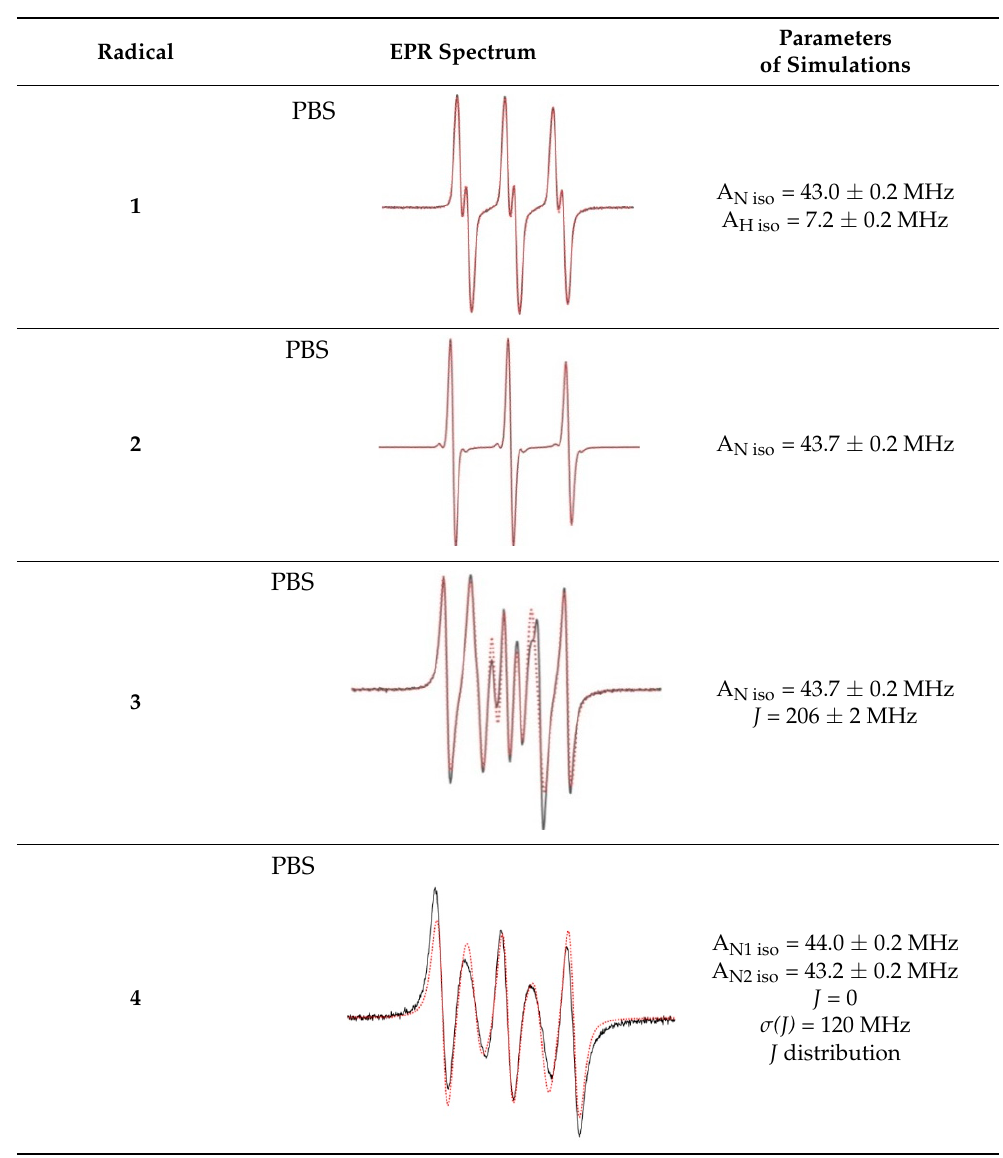
Figure 2. Left : The 94 GHz echo-detected EPR spectra (black: for 3 , red: for 4 ) at 80 K. Center : Inten- sity of spin echo of biradicals 3–4 at 80 K as a function of the time. Right : Inversion - recovery time traces of biradicals 3–4 at 80 K along with mono-exponential fits. 2.3. Relaxation Measurements The spin–lattice relaxation time of the biradicals was measured by the inversion-re- covery method (Supplementary Materials). The phase relaxation time of the samples was measured by means of primary echo decay. The obtained traces (Figure 2) were fitted by mono-exponential functions. The results of the fitting are presented in Table 2. Table 2. Parameters of relaxation times for biradicals 3–4.